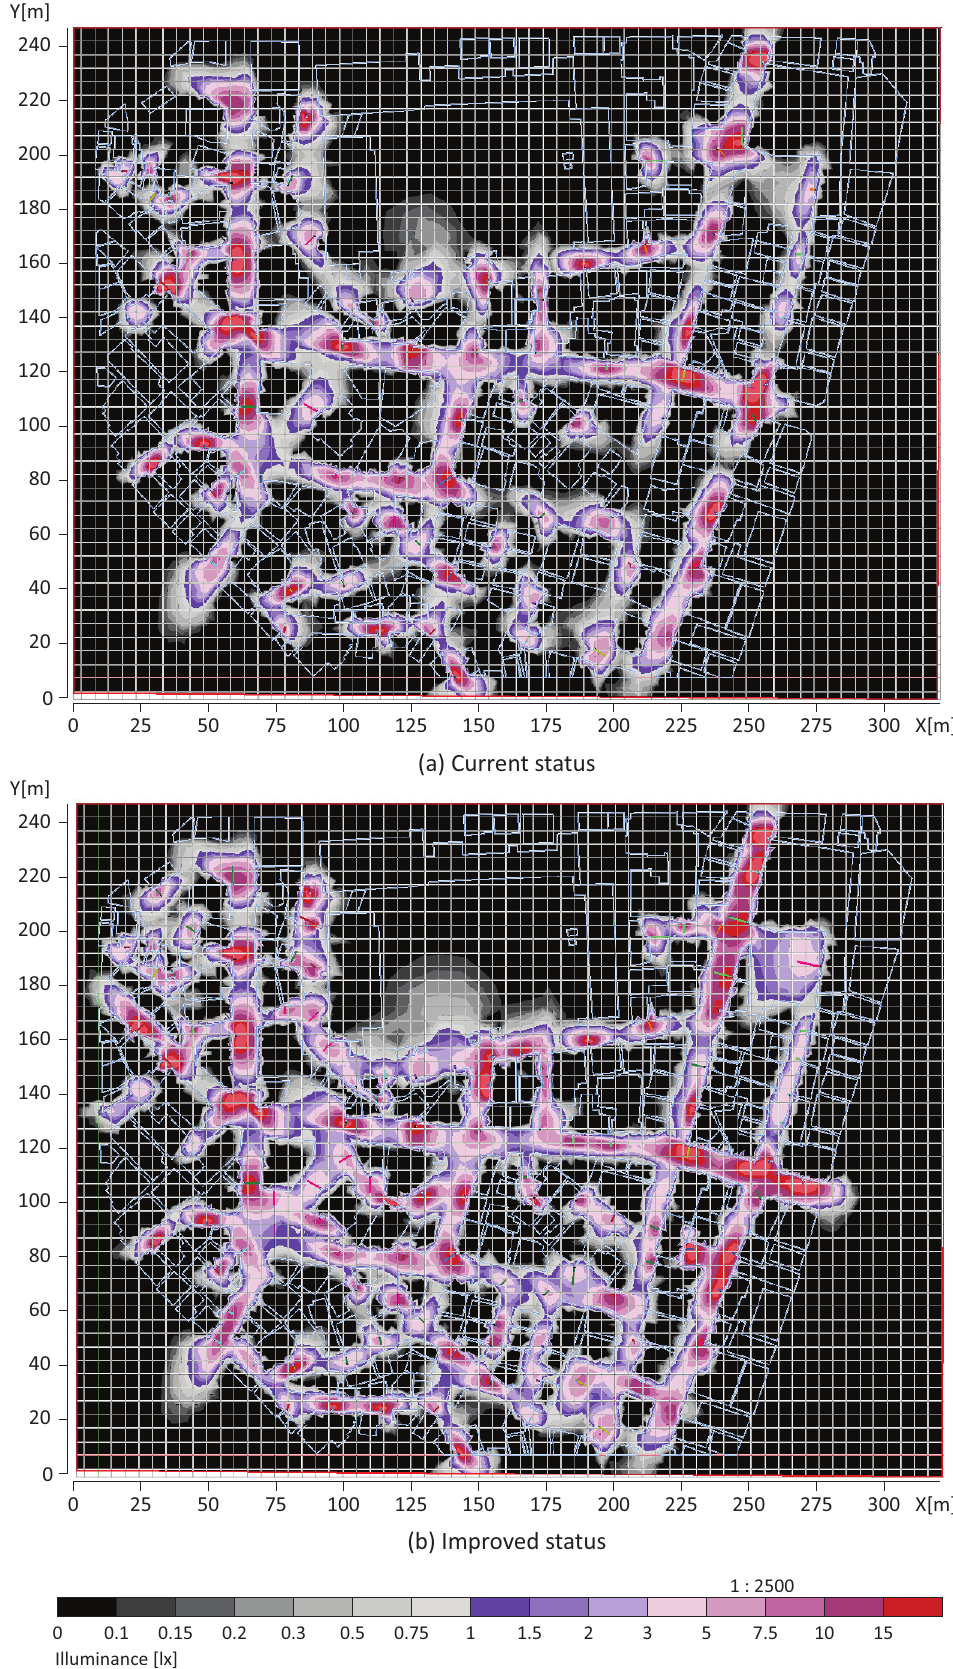
Figure 4. Changes of illuminance of street lighting at ground